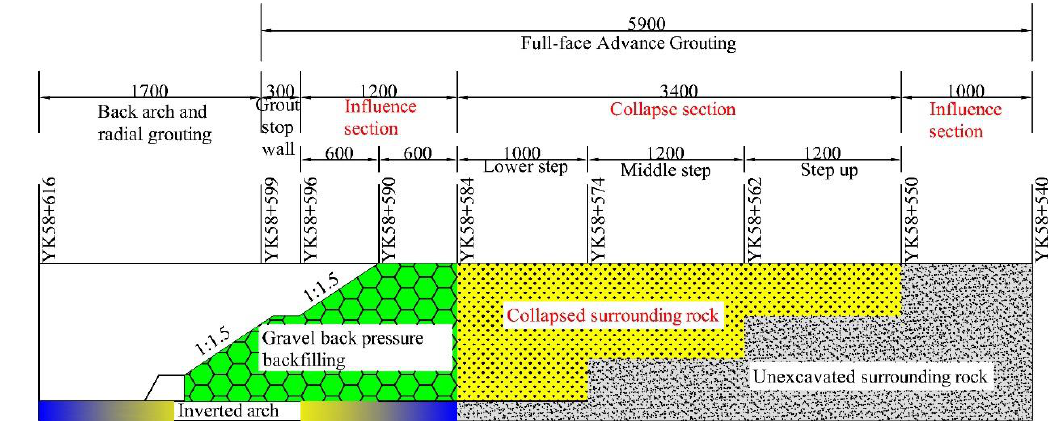
Figure 5. Vertical section of collapse treatment.